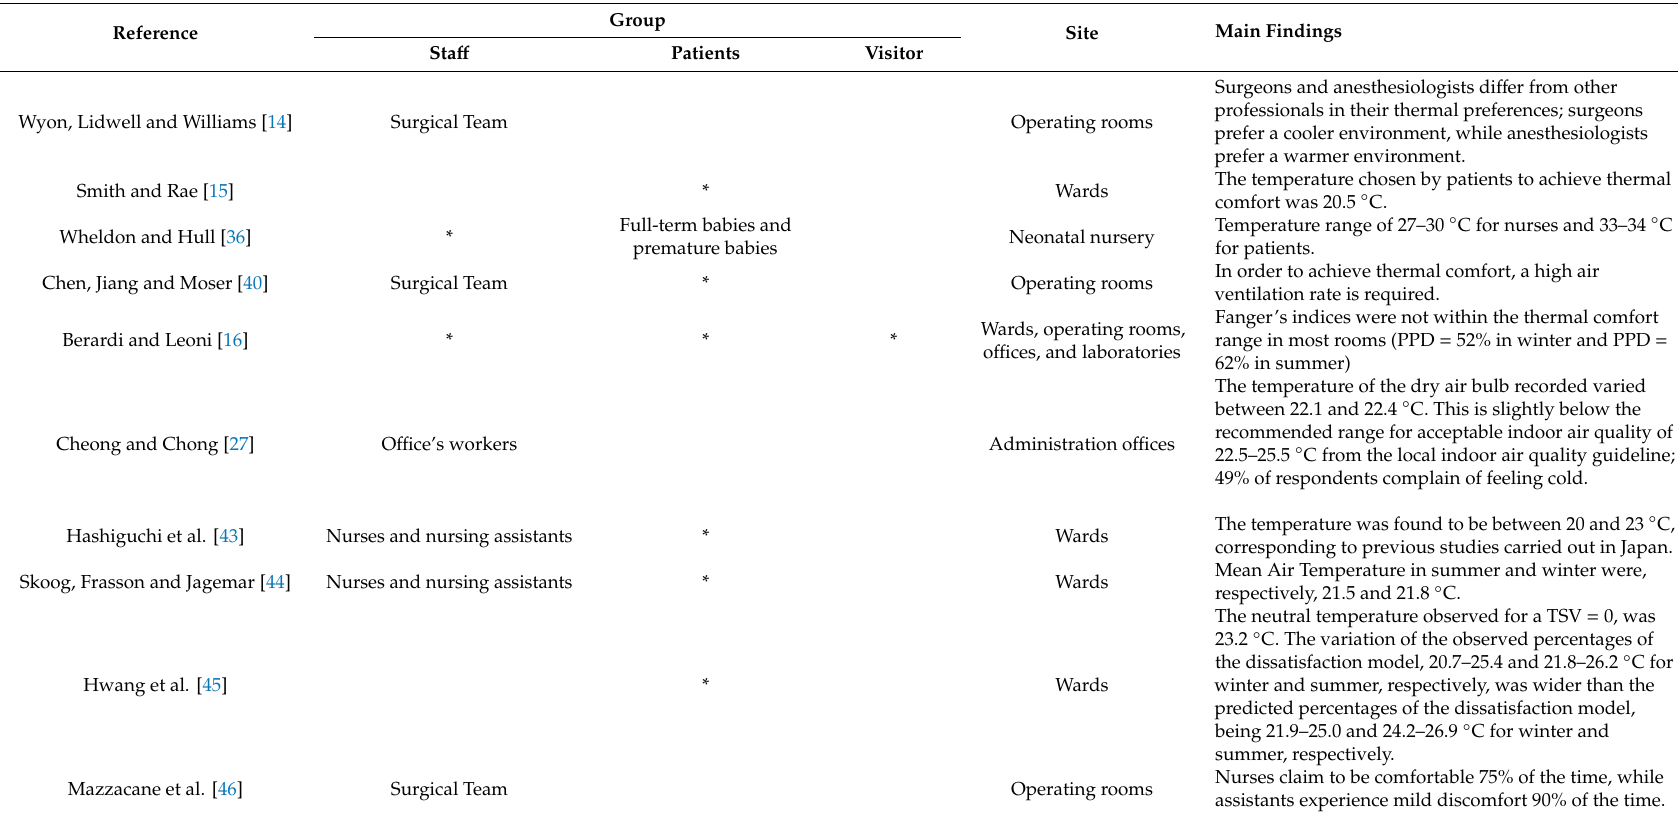
Table 9. Main finding in each